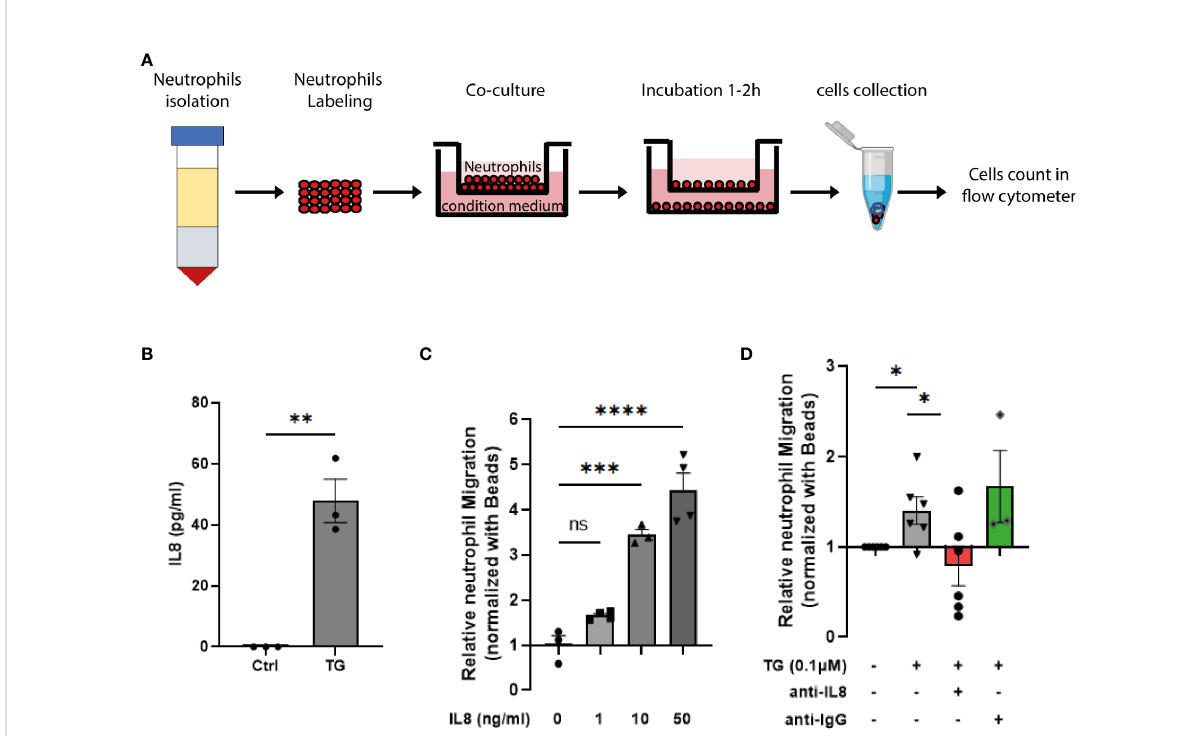
FIGURE 5 ER stress induction triggers IL8-dependent neutrophil chemotaxis. (A) Schematic representation of the transwell migration assay. (B) human IL8 ELISA performed on EndoC- b H1 cell supernatant in presence or absence of TG (0,1µM for 24h) (C) Relative neutrophil chemotaxis to recombinant human IL8 (1 – 50 ng/ml) (D) Relative neutrophil migration to conditioned medium from EndoC- b H1 treated cells. The conditioned medium from TG exposed cells were pre-incubated with either anti-IL8 blocking antibody (250 ng/ml) or anti-IgG (250 ng/ml)as negative control for 10 min. Date are expressed as mean ± SEM (n=3-5) of relative migration to the untreated conditioned medium and statistically analyzed by student ’ s t-test. Signi fi cance is indicated by *P < 0.05, **P < 0.01, ***P < 0.001, ****P < 0.0001, and ns, not signi fi